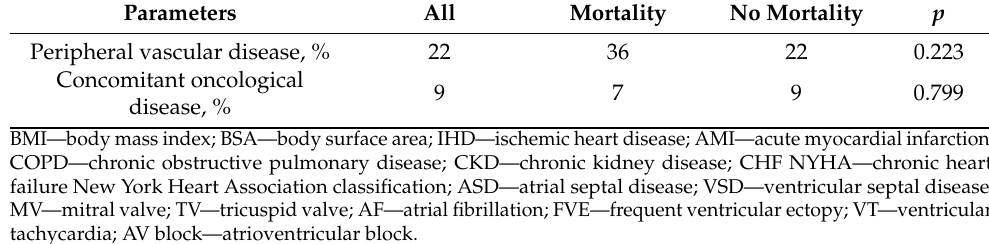
Table 1. Cont. Parameters